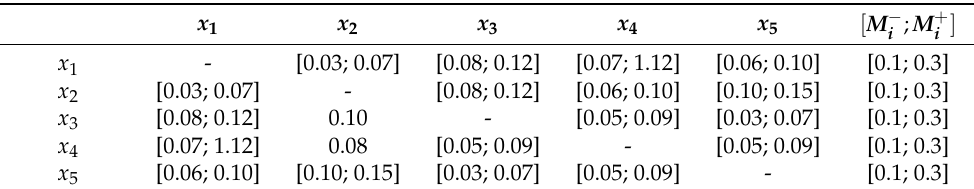
Table 1. The interval matrix of attributes pair interaction indexes— [ M − ] . ues [ M − ; M + i i